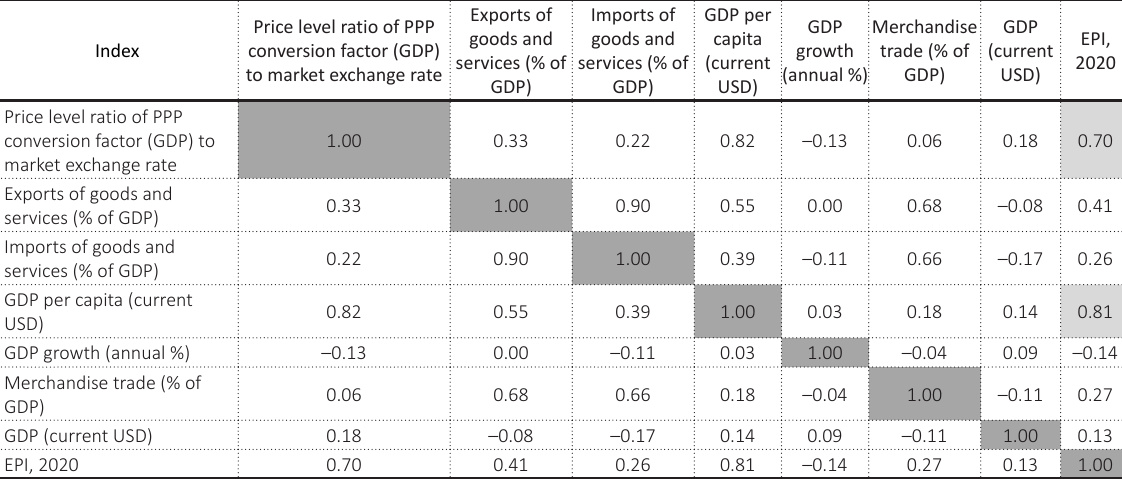
Source: Developed by the authors using RapidMiner engine.